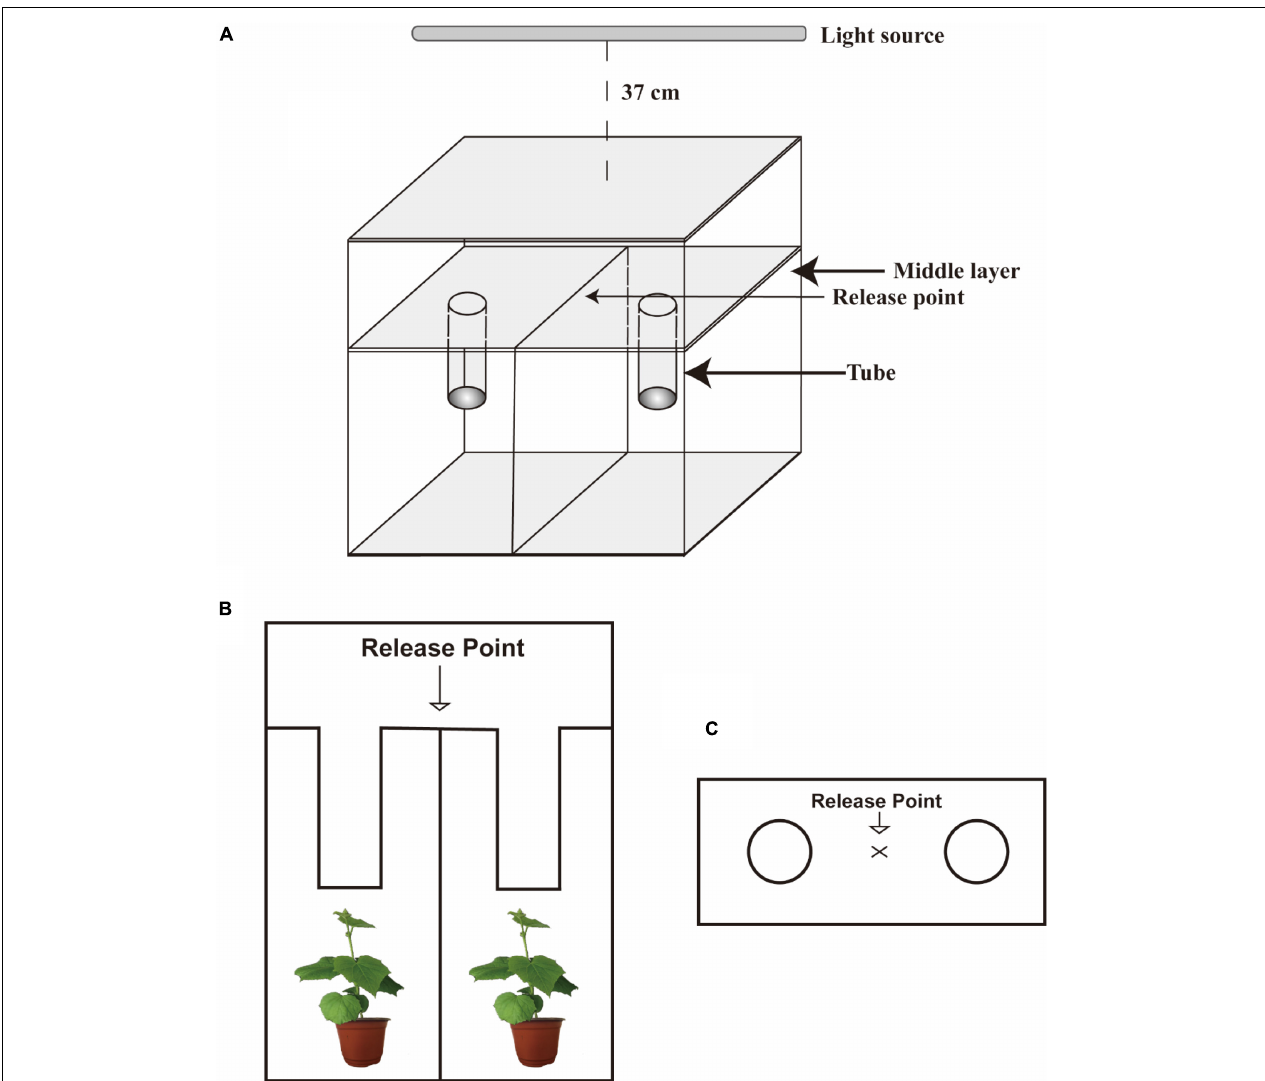
FIGURE 1 | The apparatus for B. tabaci visual preference assay 3-dimensional drawing (A) , the front view (B) , and the top view (C) of the visual selection apparatus. The apparatus is made of colorless glass (60 × 45 × 20 cm).